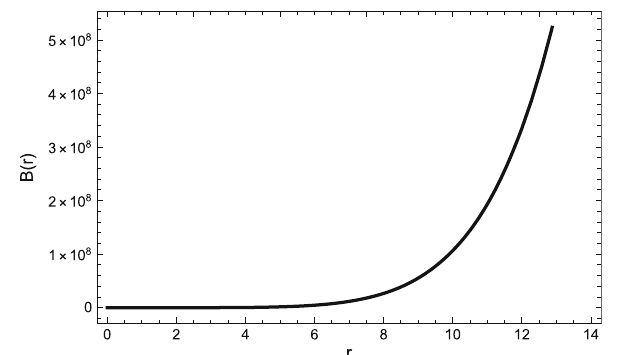
Fig. 2 Metric coefficient B ( r ) as a function of the radial coordinate r for the case of w = − 1 / 4 with α = 2, f 0 = 1 / 3, a 0 = 1, k 0 = k 1 = 1, I 3 = − 1 and I 2 = I 4 =